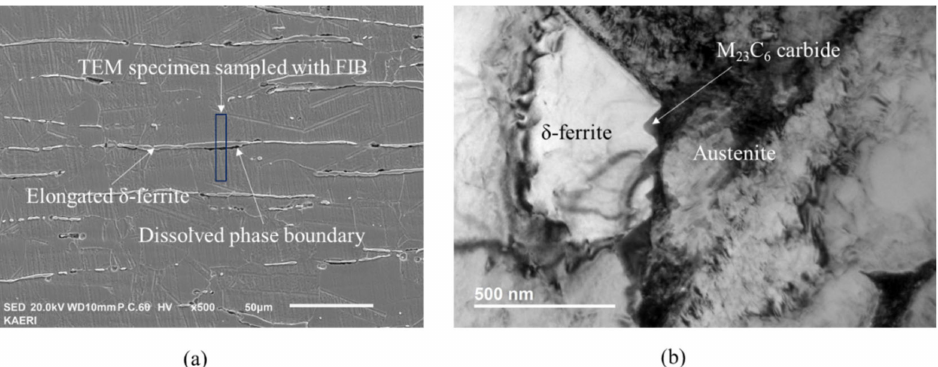
Figure 1. Microstructure of Type 304L stainless steel containing δ -ferrite sensitized at 600 ◦ C for four hours: ( a ) SEM micrograph after the DL-EPR test, showing elongated δ ferrite and partially dissolved phase boundary during the DL-EPR test; ( b ) TEM micrograph showing M 23 C 6 carbide nucleated at the phase